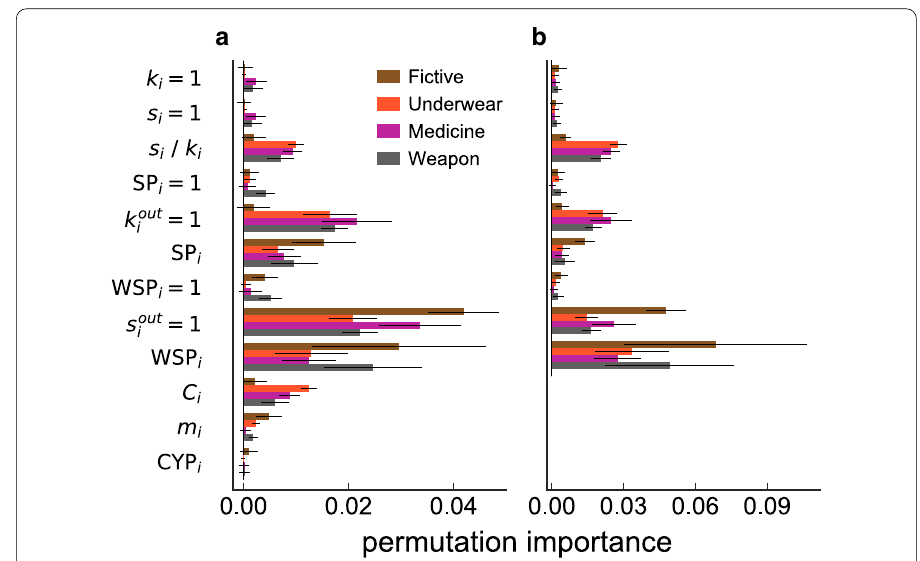
Fig. 10 Permutation importance of the features in the random forest classifier. a 12 features. b 9 features. The bars indicate the average over the 100 classifiers. The error bars indicate standard deviation